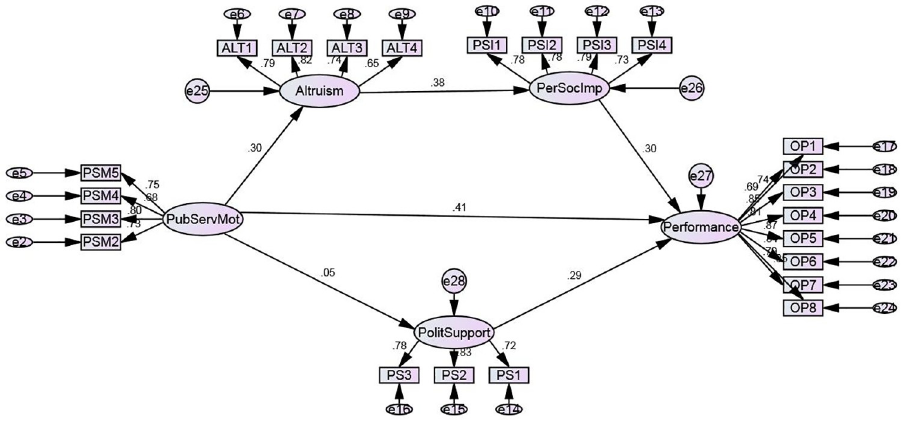
Fig 2. Structural